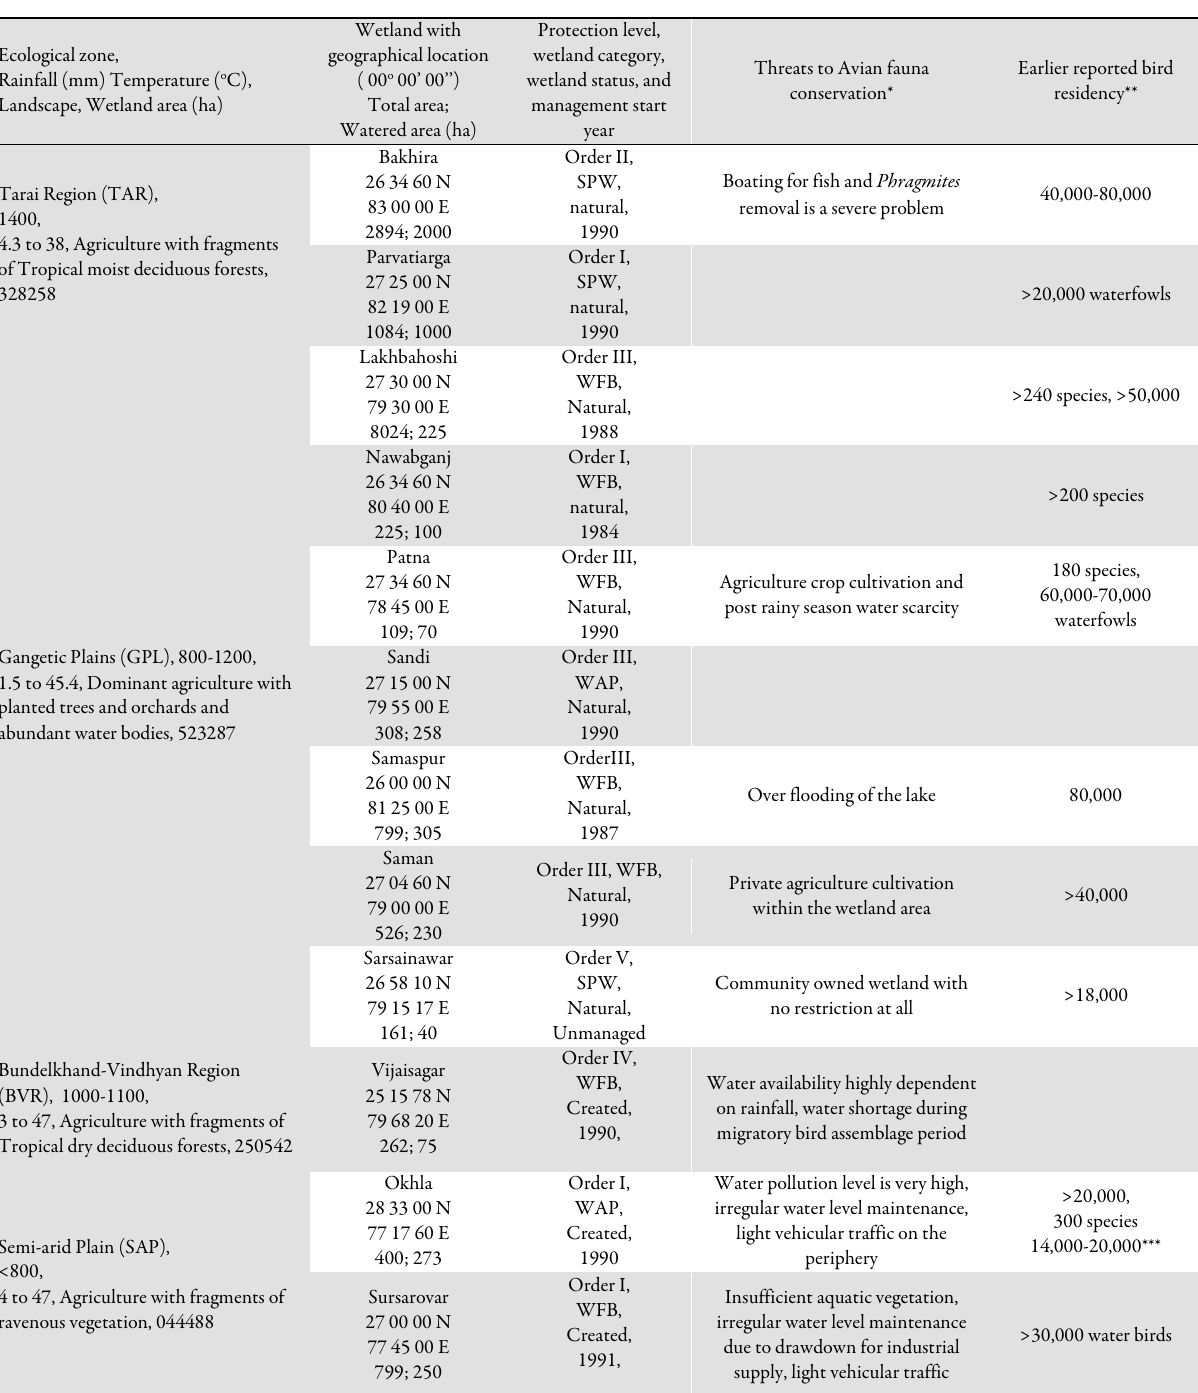
Wetland with Protection level, geographical location wetland category, ( 00 o 00’ 00’’) wetland status, and Total area; Watered area (ha)